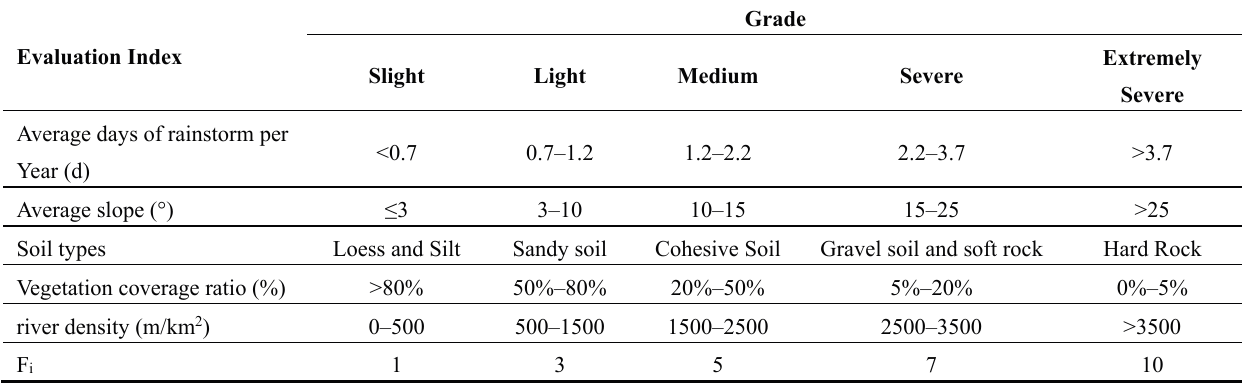
Table 2. Grades of risk evaluation indices.